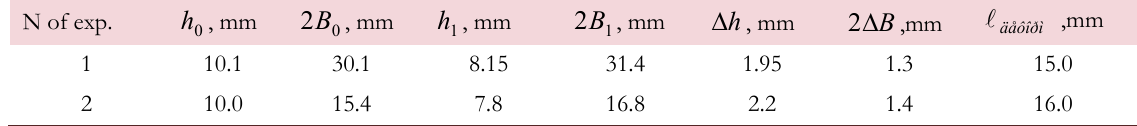
Table 1: Experimental conditions